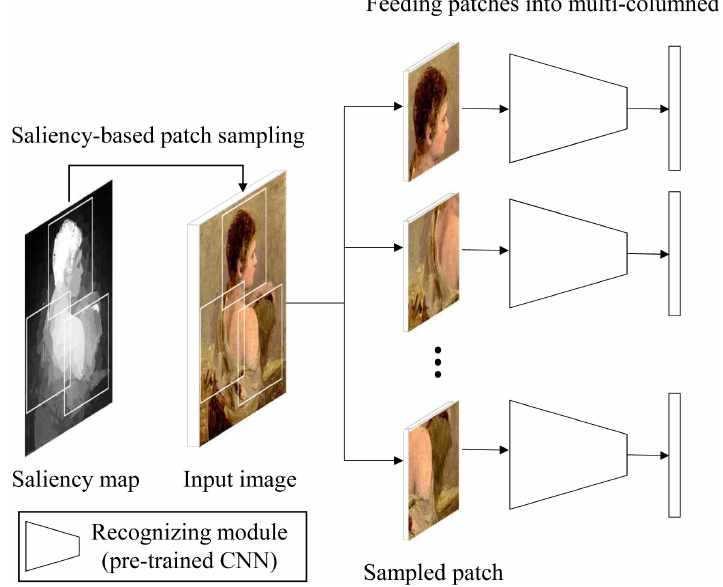
Figure 11. Our saliency-based multi-column classifier.